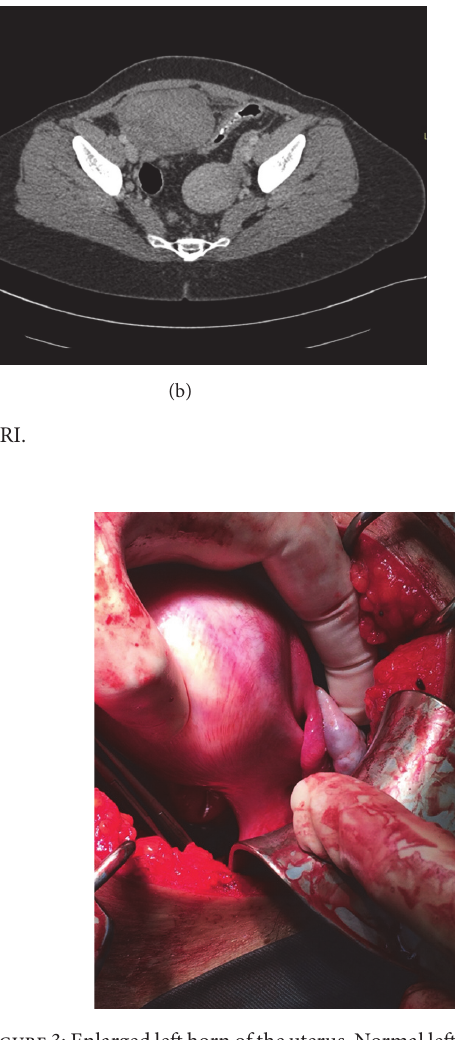
Figure 2: Twisted right adnexal mass. Figure 3: Enlarged left horn of the uterus. Normal left ovary and left fallopian